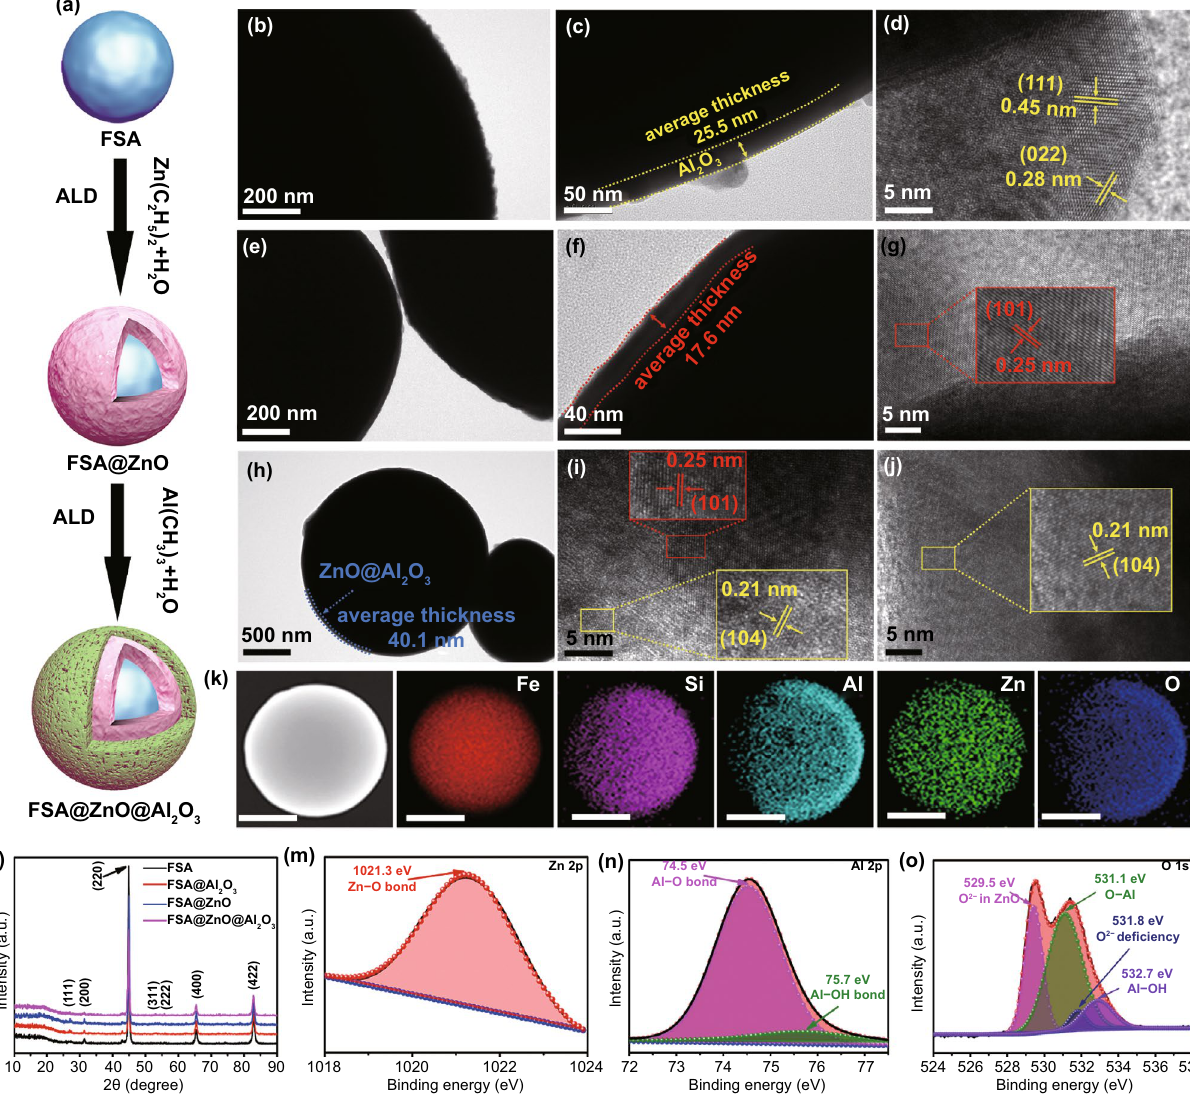
Fig. 1 a Schematic illustration of the FSA@ZnO@Al 2 O 3 gradient structure. HRTEM images of b – d FSA@Al 2 O 3 core–shell structure, e – g FSA@ZnO core–shell structure, h – j FSA@ZnO@Al 2 O 3 gradient structure. k TEM element distribution of FSA@ZnO@Al 2 O 3 gradient struc- ture. The scale bar in all Figures is 1 μm. l XRD patterns. High-resolution XPS spectra of FSA@ZnO@Al 2 O 3 gradient structure: m Zn 2p, n Al 2p, o O 1s